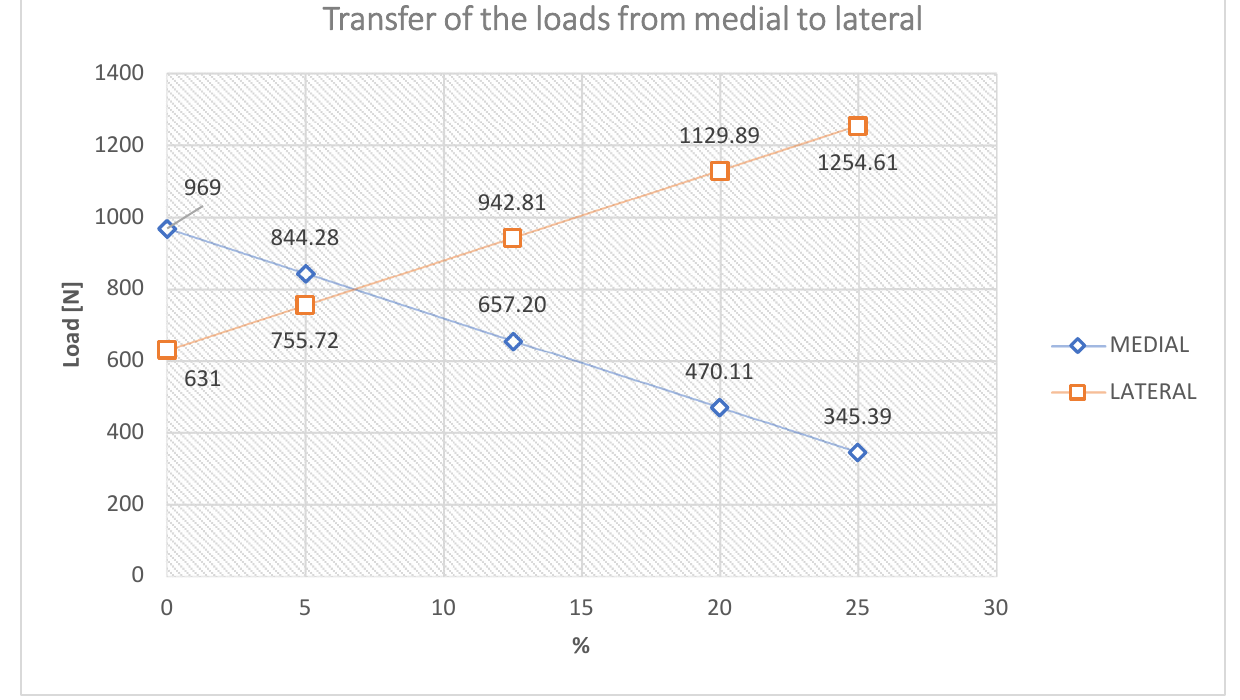
Figure 10. Transfer of the load medial–lateral tibial plateau.